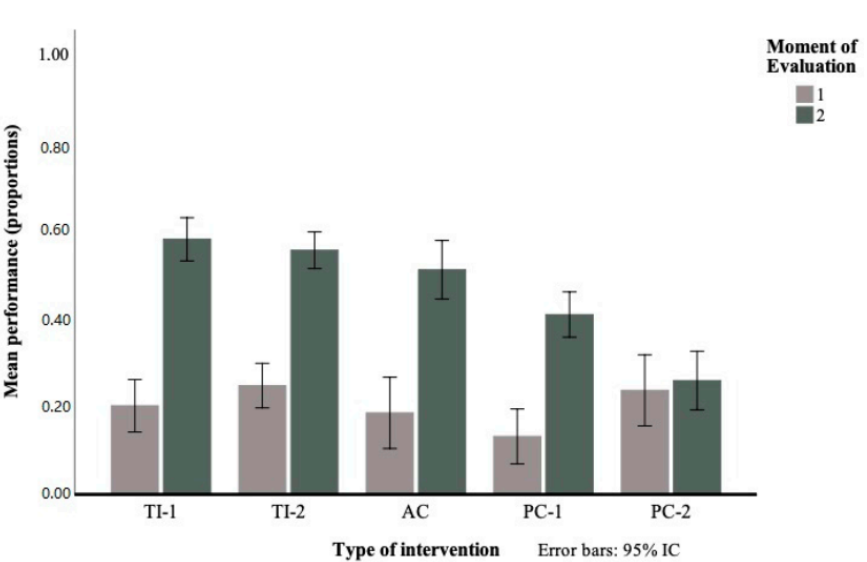
Figure 3. Interaction Type of Intervention x Moment of